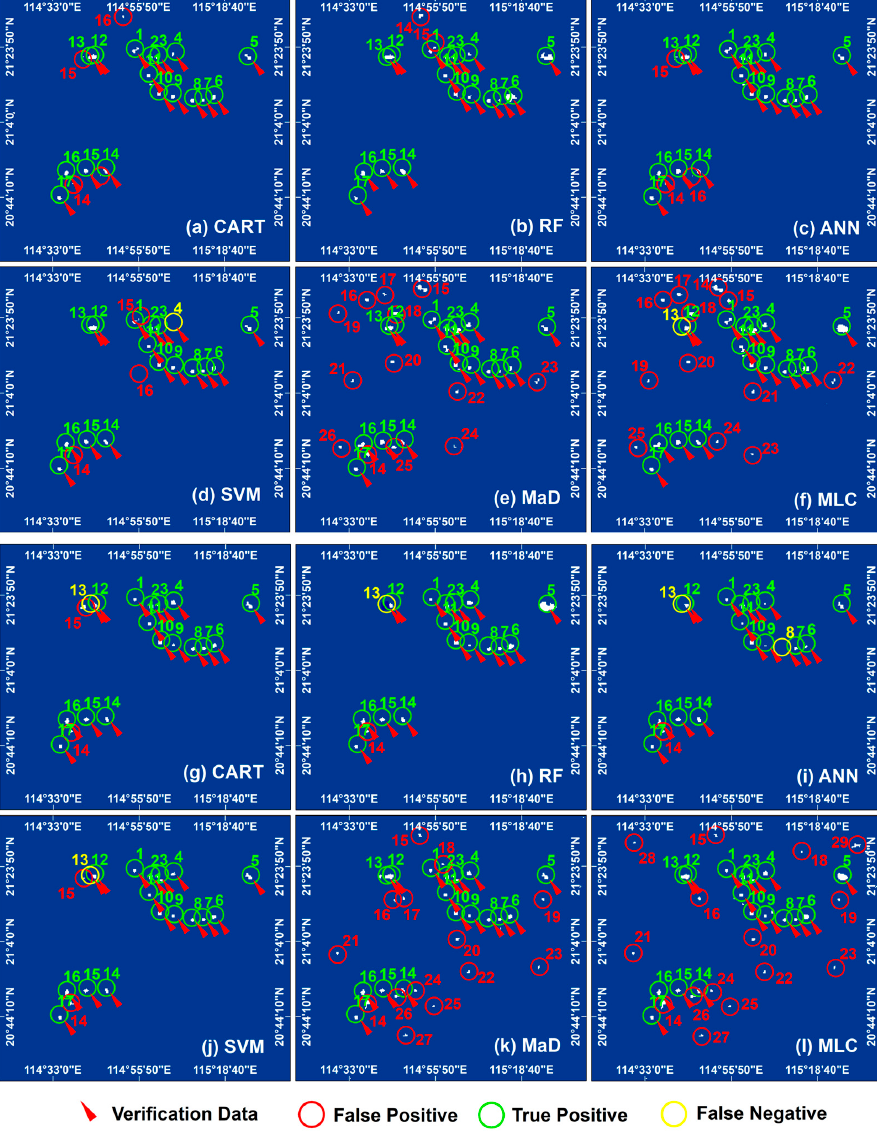
Figure 4. Extraction results of the targets in region 1, located in the Pearl River Mouth Basin: ( a – f ) are the extraction results in 2016; ( g – l ) are the extraction results in 2017. Red arrows are the validation targets; green circles are the correctly extracted targets; yellow circles are the omissive targets; red circles are the incorrectly extracted targets.